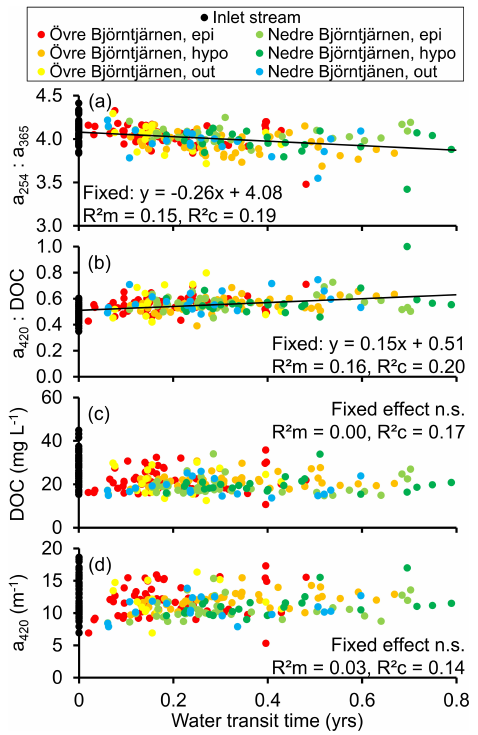
Figure 1. Relationships between dissolved organic carbon (DOC) properties and the water transit time in two chain lakes with 92% shared catchment area. The y axis variables are (a) the ratio between the absorbance at the wavelengths of 254 and 365nm, (b) the ratio between absorbance at 420nm and DOC, (c) DOC concentration, and (d) absorbance at 420nm ( n = 260, study years 2006–2014). Solid lines are based on significant ( p < 0 . 01) fixed-effects coef- ficients and intercepts. The R 2 m shows marginal R 2 for fixed ef- fects, where water transit time is the fixed effect, and the R 2 c refers to conditional mixed-effects models in which site is included as a random effect (on intercept only, not slope). Inlet samples during drought (lower 5 percentiles of flow) are not included since drought inflow makes a negligible contribution to the water that resides in the lakes. In Fig. S4 all DOC property data from this figure are plot- ted over a calendar time line. Abbreviations: n.s. – not significant; epi – epilimnion; hypo – hypolimnion; out – outlet.